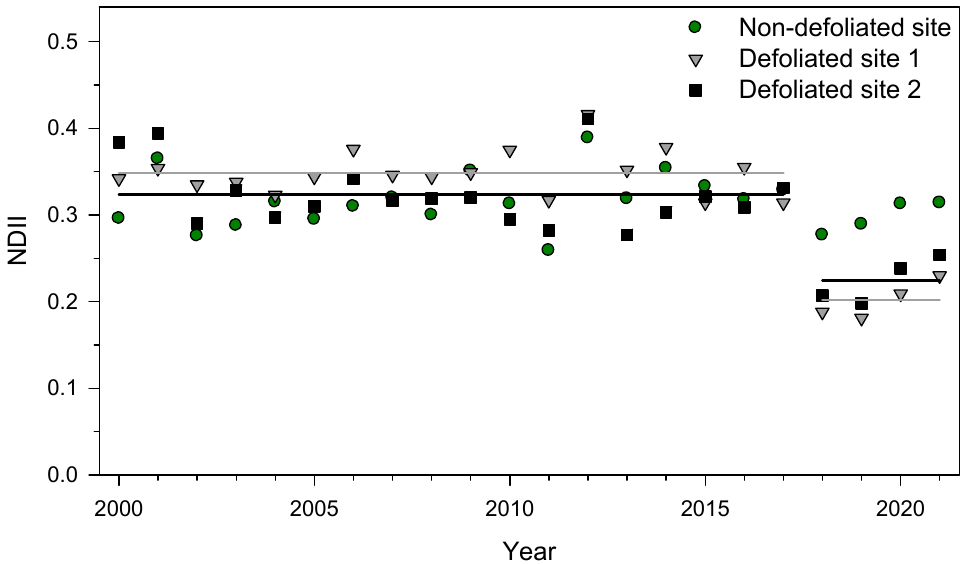
Figure 3. The horizontal lines show a regime shift in 2018 corresponding to significant ( p < 0.01) values of the regime shift index in the two defoliated sites (defoliated site 1, grey symbols and line; defoliated site 2, black symbols and line). Green symbols show NDII values for the non-defoliated site.